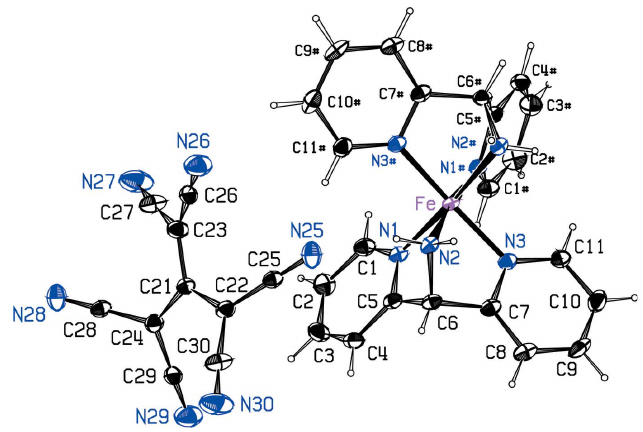
Figure 1 The [Fe(dipa 2 )] 2+ cation and tcpd 2 (cid:2) anion in the title compound. Atoms in the cation with the # suffix are related to the asymmetric unit by (1 (cid:2) x , y ,